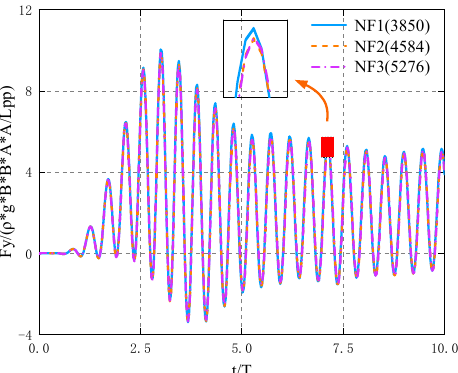
Figure 8. Time history diagram of the sway wave drift force of the KVLCC2 ship under different panel numbers of the free surface.